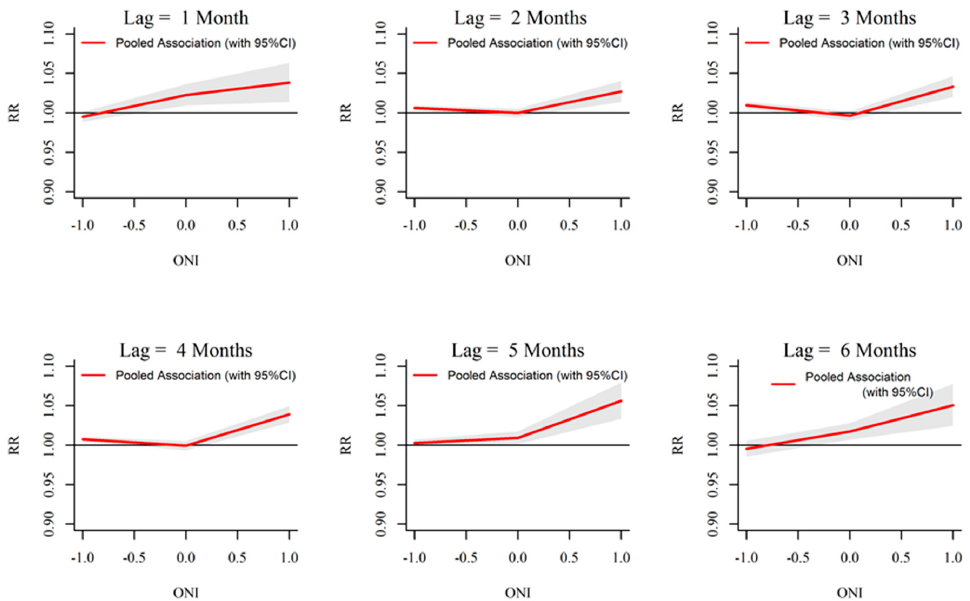
Figure 9. Relative risk (RR) of monthly mean temperature by ONI at specific lags in 10 MOH divisions in Kalutara district, Sri Lanka, 2009–2013. The figure illustrates the predicted curves from meta-regression for different lag periods; 1, 2, 3, 4, 5 and 6 months. The shaded areas represent 95% confidence intervals.